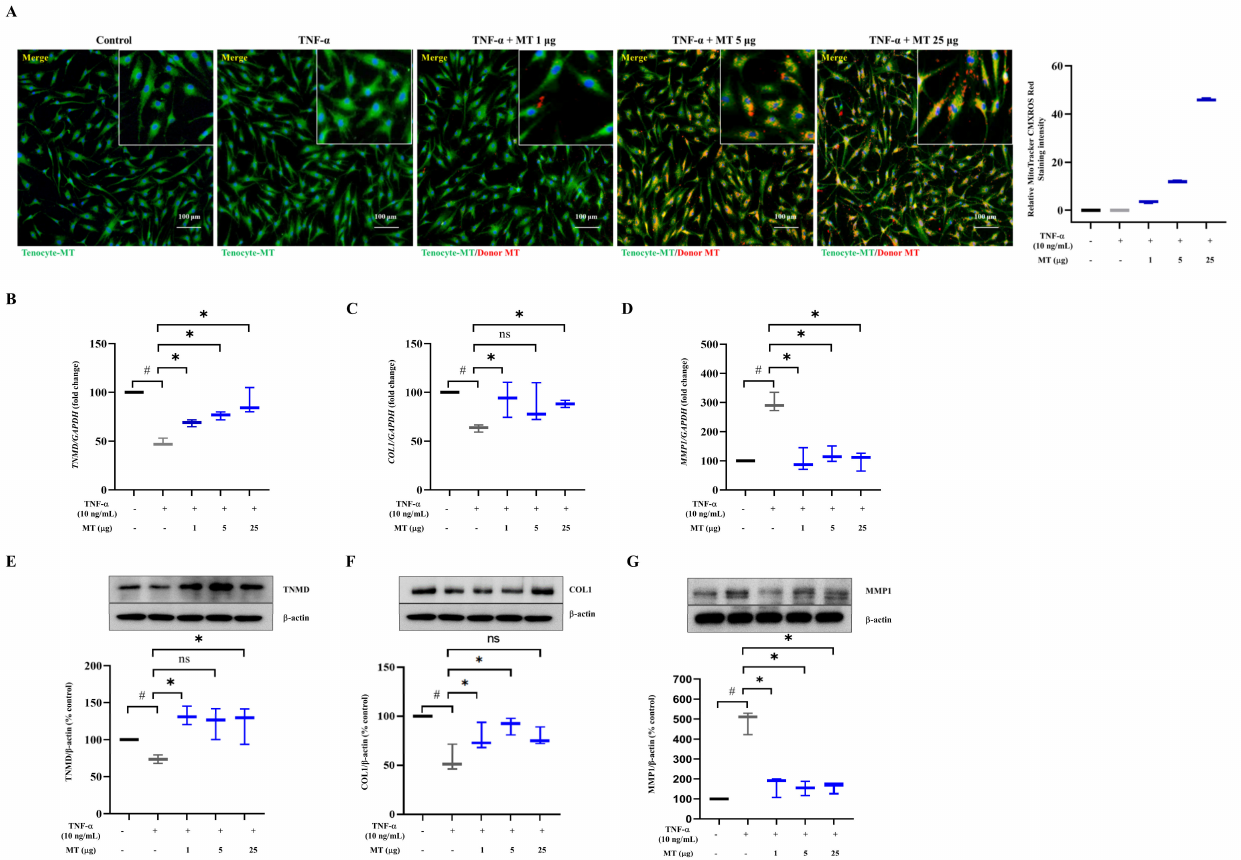
Figure 1. Exogenous mitochondria successfully transplanted into damaged tenocytes enhance tenocyte-related marker levels and decrease MMP1 level. ( A ) Representative fluorescence images of tenocytes showing endogenous mitochondria (MitoTracker Green) and increased doses (1, 5, 25 µ g) of exogenous mitochondria (MitoTracker CMXR OS red) with DAPI nuclear staining (blue). Red fluorescent signal intensity increased dose dependently. ( B – D ) Gene expression of ( B ) TNMD , ( C ) COL1 , and ( D ) MMP1 ( GAPDH as loading control). ( E – G ) Representative western blots and densitometric quantification of ( E ) TNMD, ( F ) COL1, ( G ) MMP1 ( β -actin as loading control). Data represent mean ± standard deviation (SD) ( n = 3). # p < 0.05 between TNF- α (+) group (black) and TNF- α ( − ) group as control (white), * p < 0.05 between MT (+) group damaged by TNF- α (gray) and MT ( − ) group damaged by TNF- α (black) TNF- α , tumor necrosis factor- α ; MT, mitochondria; TNMD, tenomodulin; COL, collagen; MMP1, matrix